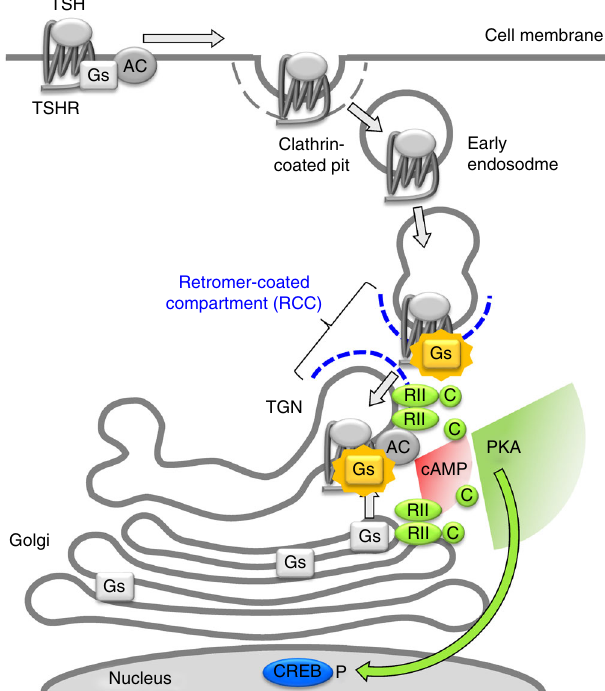
Fig. 8 Model proposed for TSHR signaling at the TGN based on the results of this study. Upon TSH stimulation, TSH/TSHR complexes internalize and traf fi c retrogradely to the TGN, leading to local G s -protein activation in the retromer-coated compartment (RCC) and cAMP/PKA signaling at the Golgi/TGN, which is critically positioned near the nucleus. This appears required for ef fi cient PKA-dependent CREB phosphorylation and the induction of early genes in response to TSH, which in thyroid cells is known to ultimately lead to increased thyroid hormone production and cell